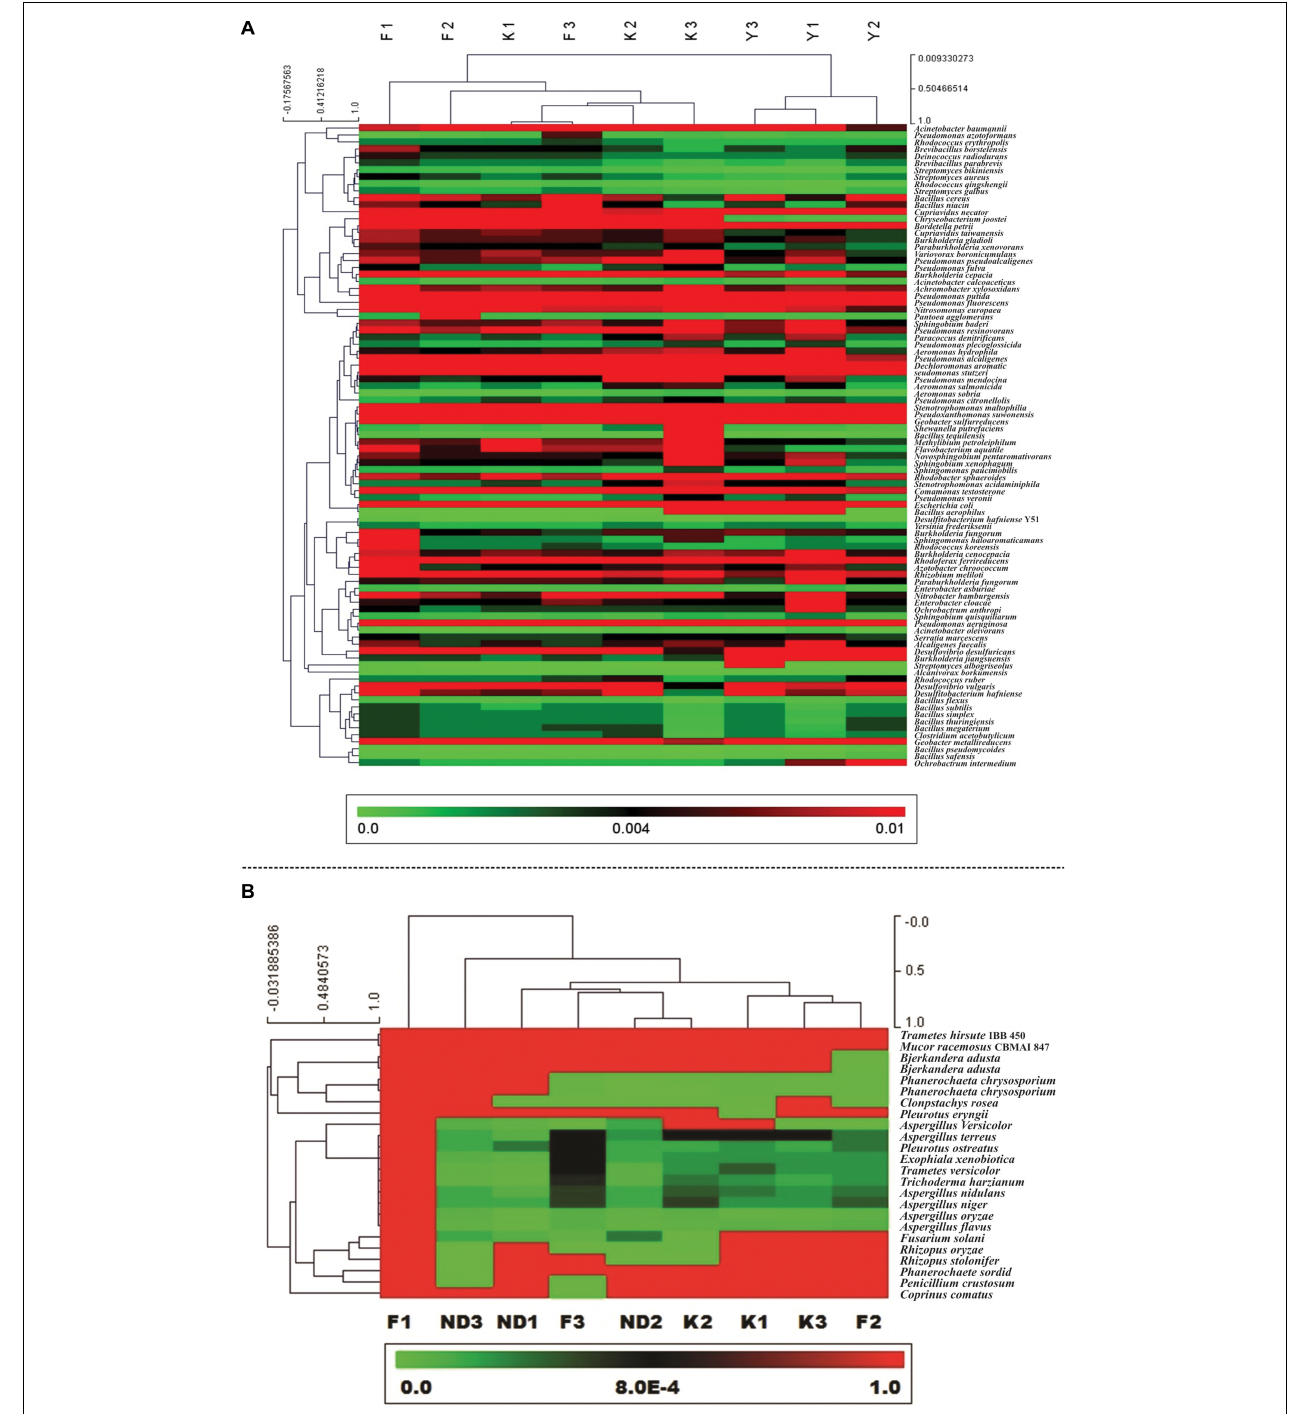
FIGURE 3 | Relative abundance Heat map of identified 92 bacterial species (A) and 24 fungal species (B) having bioremediation potential from nine different sediment metagenomes of river Ganga and Yamuna.